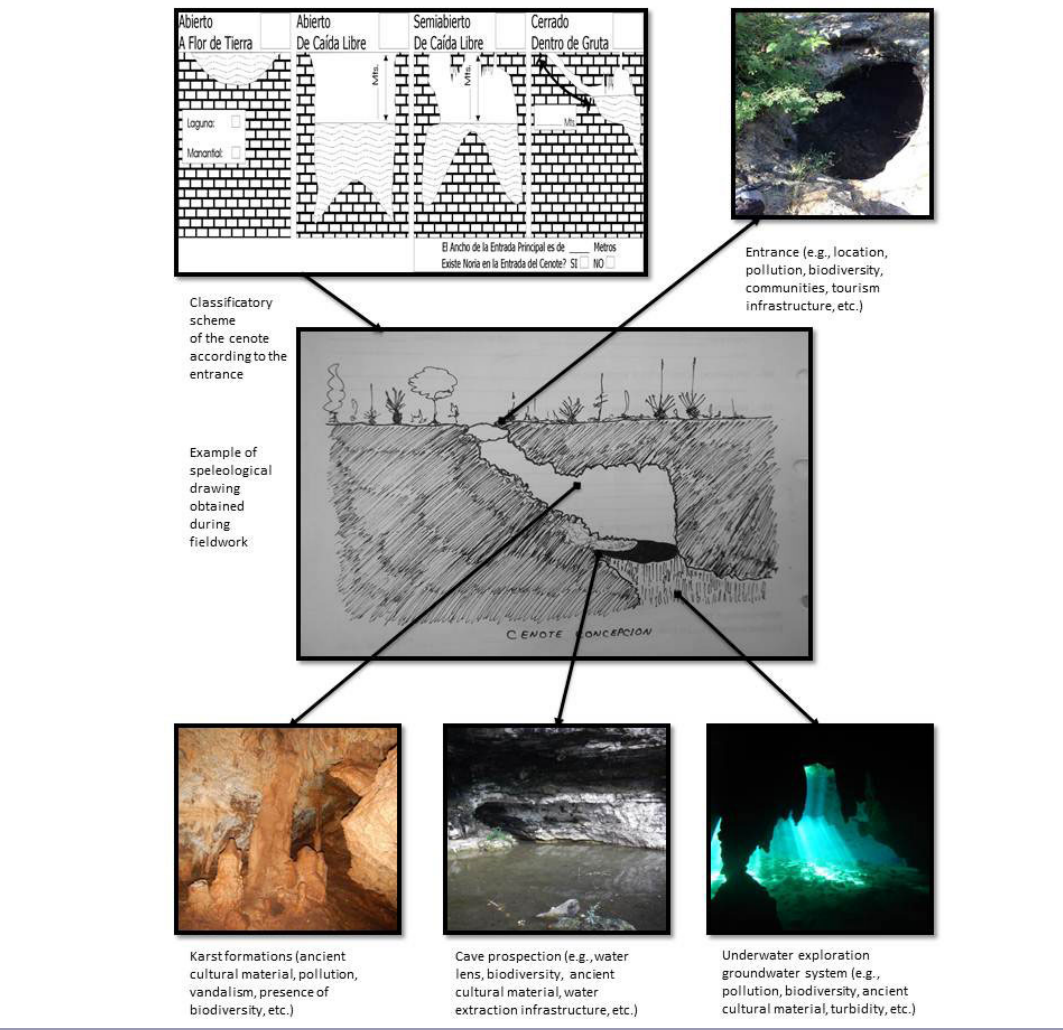
Fig. 4 . Example of information obtained to create the index cards used to explore cenotes.